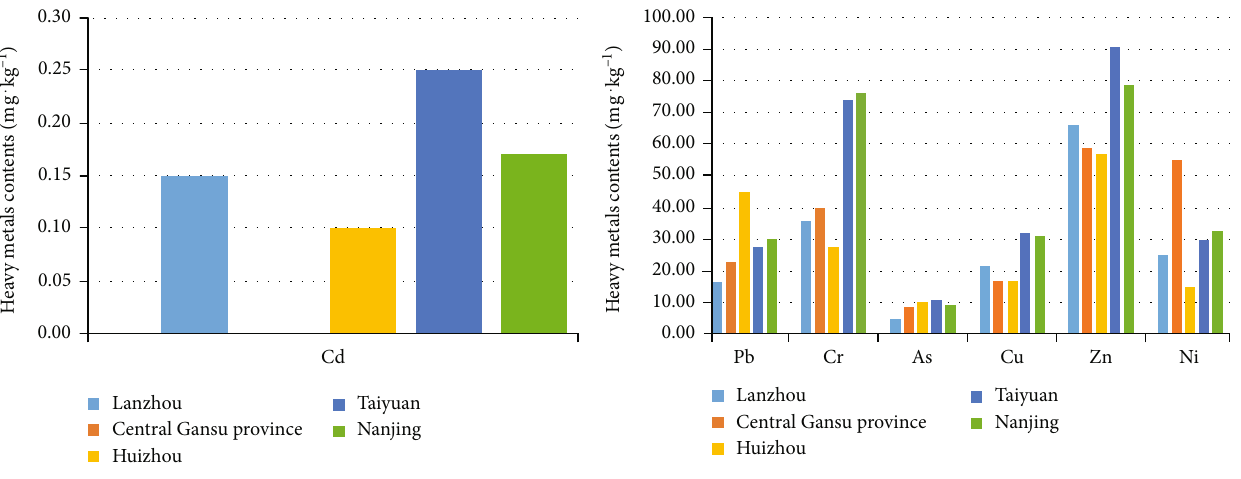
Figure 5: The histogram of heavy metal concentrations in di ff erent cities of China. Table 9: Summary of the mean values of heavy metal concentrations in di ff erent